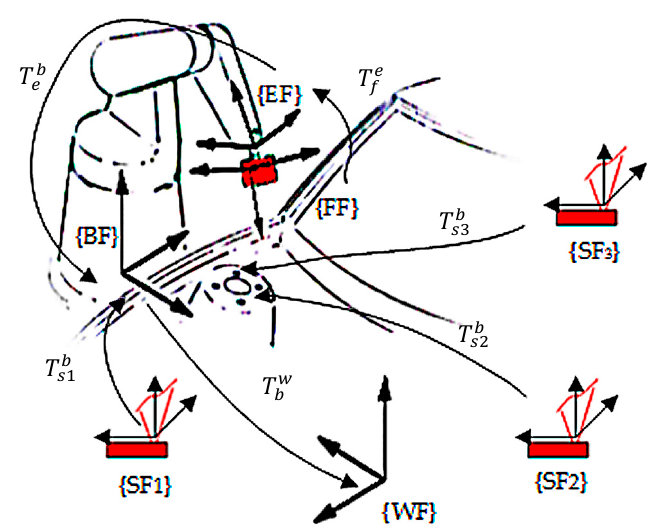
Figure 1. Schematic of the hybrid visual inspection system.